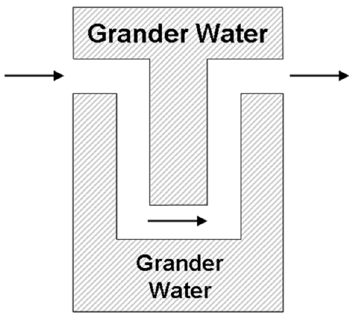
Figure 11. Diagrammatic representation of the Grander water purification